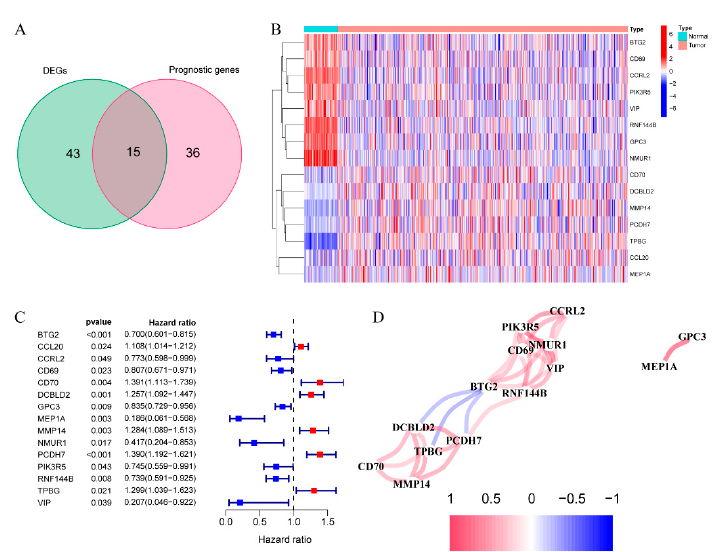
Figure 1. Discovery of the 15 IRGs from TCGA dataset. ( A ) DEGs in LUAD samples compared with the non-carcinoma samples. ( B ) The levels of 15 candidate genes in LUAD samples compared with non-carcinoma samples. ( C ) Association of the 15 putative gene levels with OS. ( D ) Putative gene correlation network.